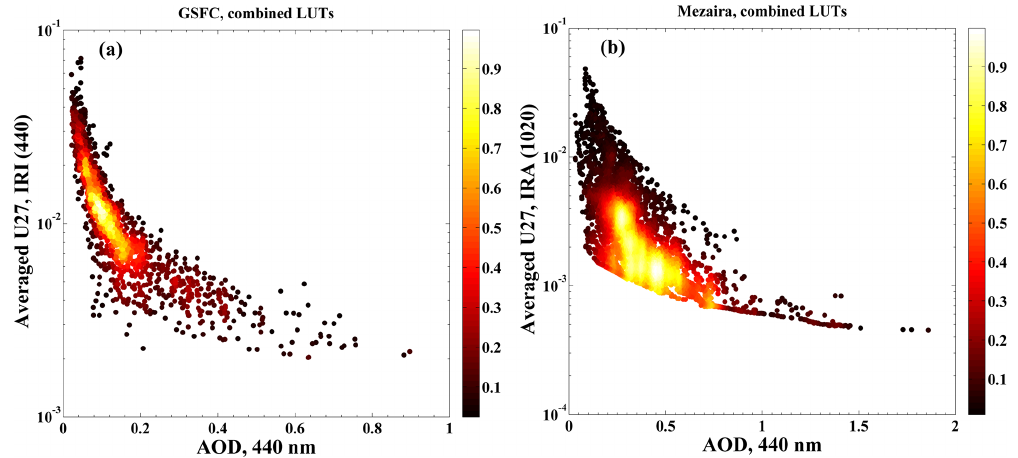
Figure 23. Uncertainties of the imaginary part of refractive index estimates: (a) GSFC and (b) Mezaira.